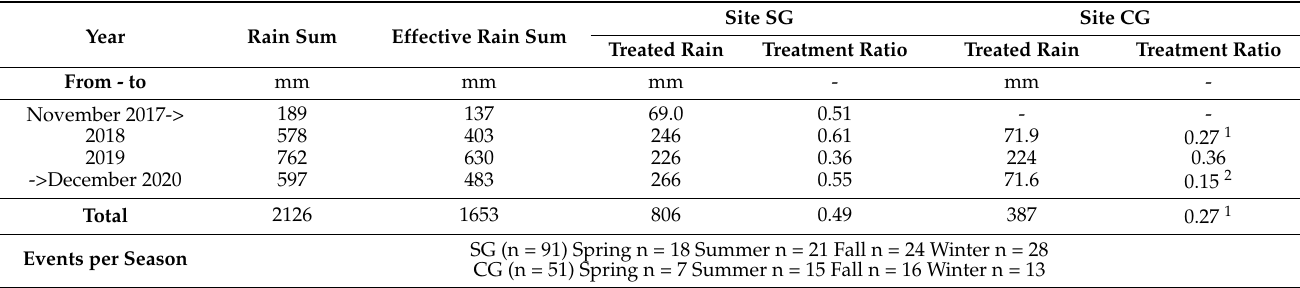
Table 6. Precipitation representativity and seasonal distribution of events at site SG and CG.